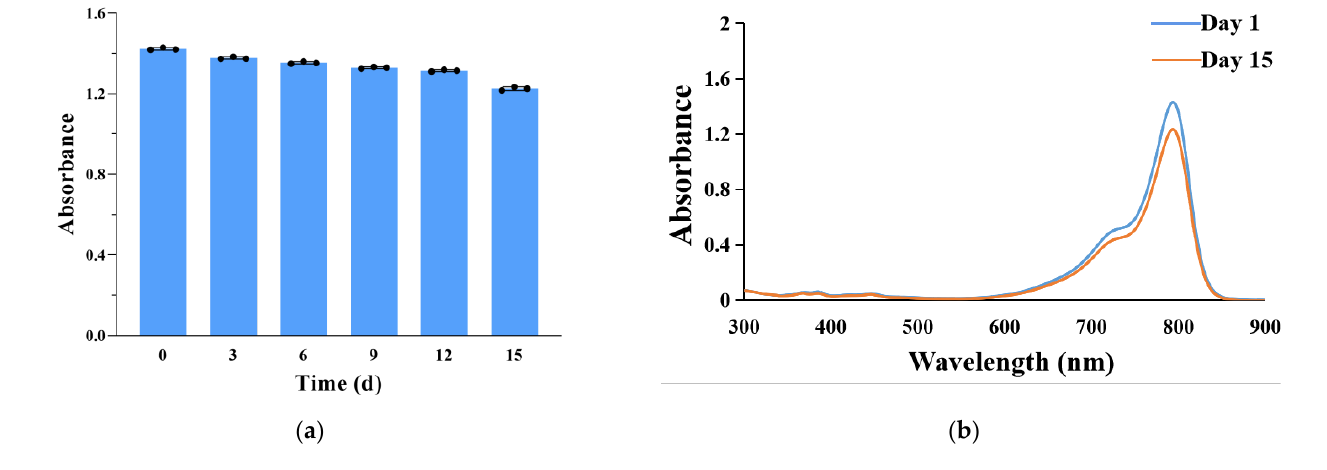
Figure 7. ( a ) The change in absorbance of CCIPNs during storage at 4 ◦ C for 15 days. ( b ) The change in ultraviolet–visible light absorption spectrum of CCIPNs during storage at 4 ◦ C for 15 days. Values are expressed as mean ± SD ( n = 3). Each dot represents an independent